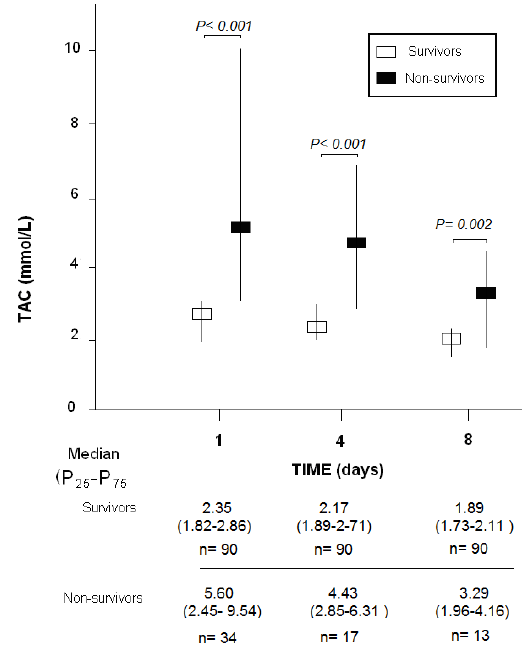
Figure 1. Serum total antioxidant capacity (TAC) levels at day 1, 4, and 8 of traumatic brain injury in 30-day surviving and non-surviving patients. Table 2. Thirty-day mortality prognostic capability of serum total antioxidant capacity (TAC) levels at day 1, 4, and 8 of trauma brain injury.